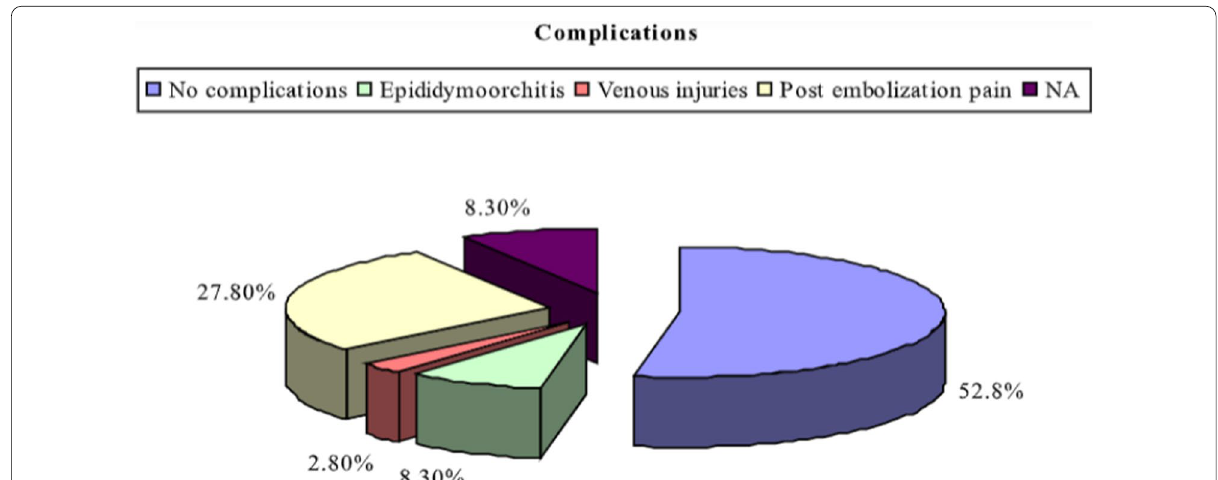
Fig. 7 Pie chart for post-intervention complications percentages (NA